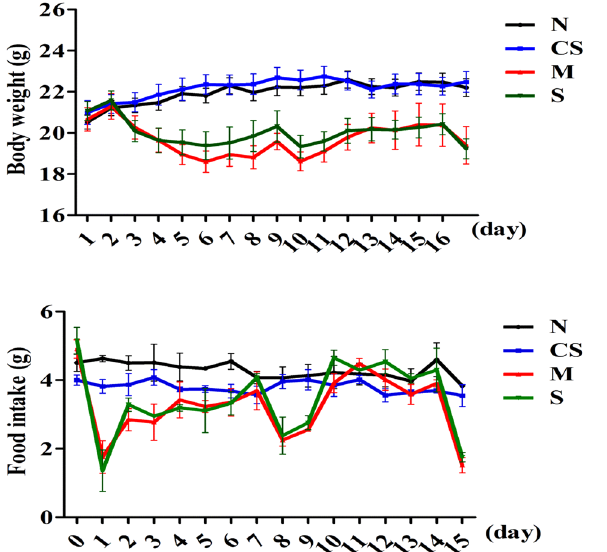
Figure 1. The changes in bodyweight and feed intake during the 16-day experimental period. N: healthy mice + PBS; CS: healthy mice supplemented with a daily dose of 150 mg/kg bodyweight of CS disaccharides for 16 days; M: mice subjected to exhaustive exercise stress + PBS; S: the stressed mice supplemented with a daily dose of 150 mg/kg bodyweight of CS disaccharides for 16